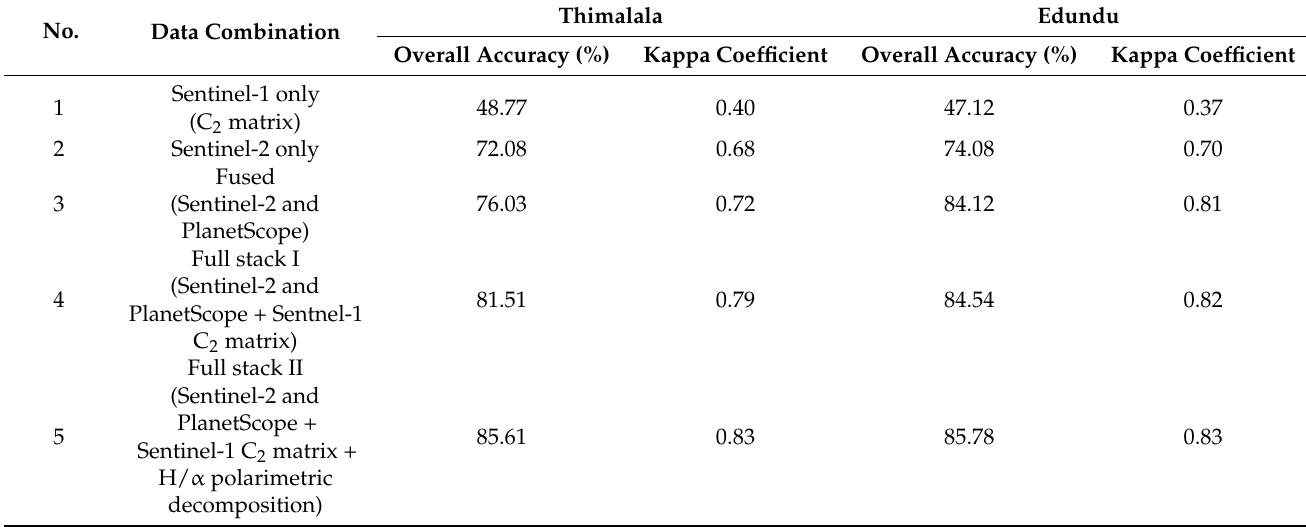
Table 4. Comparison of the accuracy assessment results of the random forest